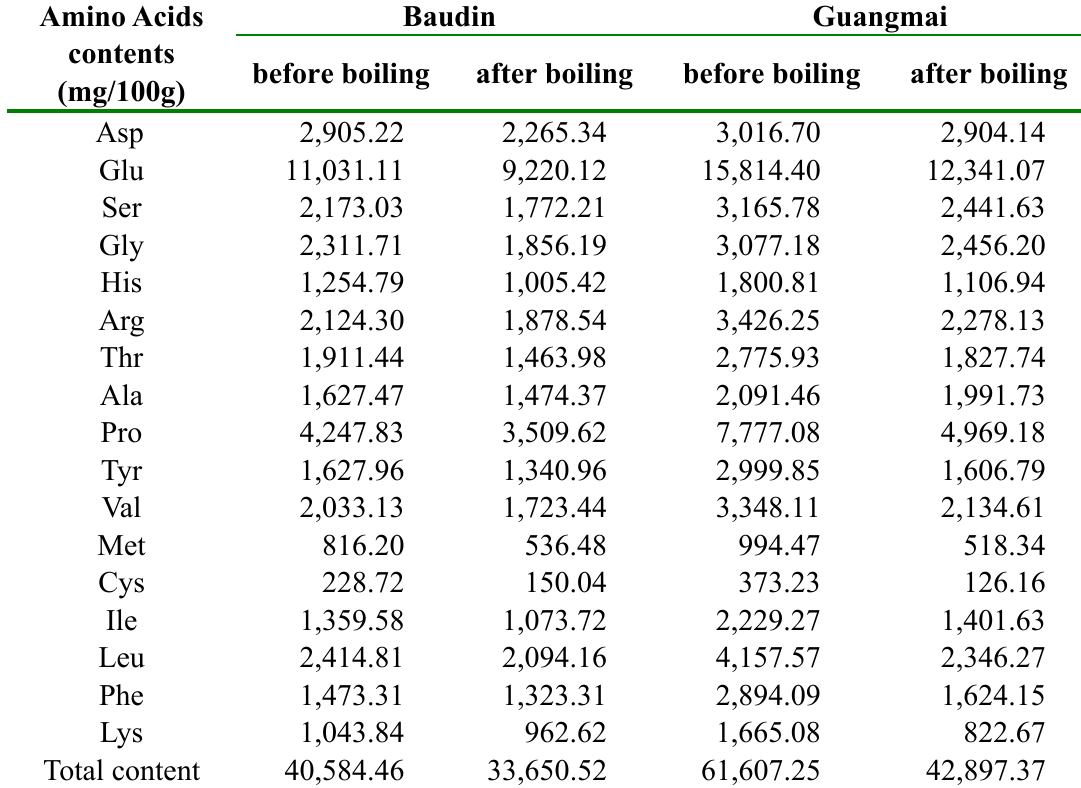
Table 2 . Changes in amino acid contents of the two wort varieties during boiling a